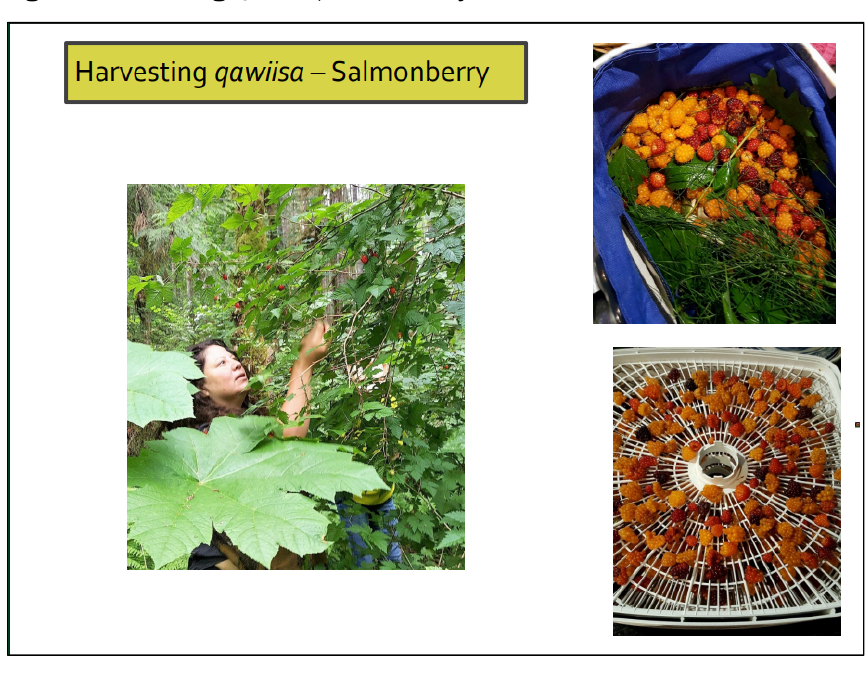
Figure 8. Harvesting Devils’